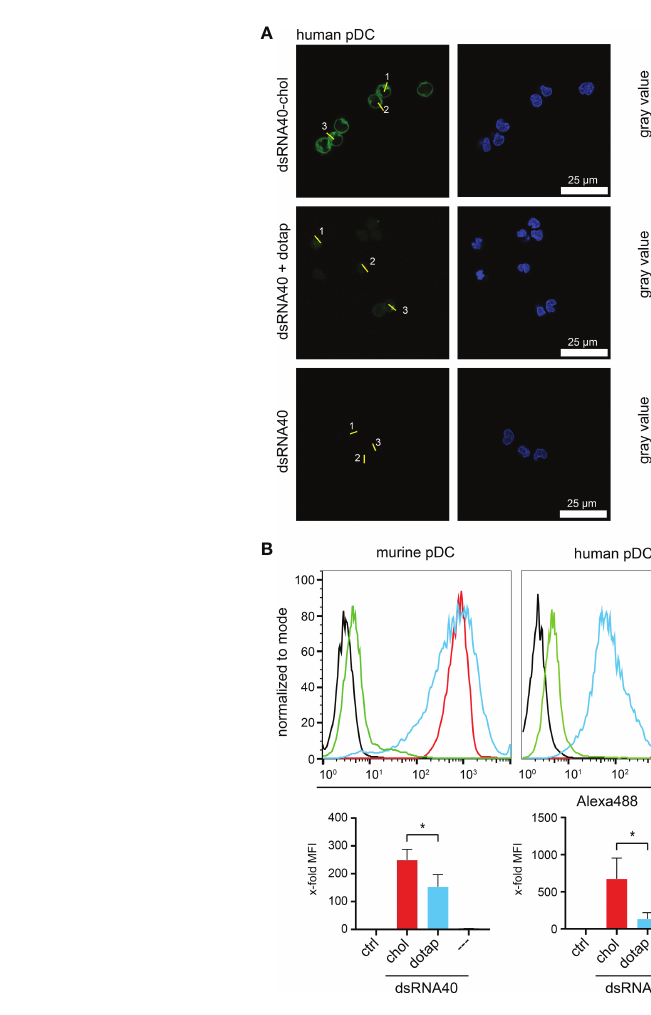
FIGURE 4 | dsRNA40-chol nanoparticles are ef fi ciently taken up by different immune cells. (A) Puri fi ed human pDC were incubated with 0.5 µM of Alexa488-labeled dsRNA40-chol, dsRNA40 complexed to DOTAP or dsRNA40. Cells were extensively washed and fi xed after 1.5 h of incubation and analyzed by confocal laser scanning microscopy. RNA40 is shown in green and DAPI-stained nuclei in blue (left panel, scale bar 25 µm). In the right panel, the fl uorescence intensity pro fi le is plotted as grayscale ( fl uorescence intensity) versus distance (in µM) for individual cells. For every cell stimulation condition, 3 cells were marked by a line (numbered from 1 to 3) and corresponding fl uorescence pro fi le (numbered from 1 to 3) plotted along this line. (B) Murine Flt3L-DC (B220+/CD11c+ pDC), puri fi ed human pDC and monocytes were incubated as described in (B) and uptake of RNA40 was analyzed by fl ow cytometry. Histograms depict one representative experiment out of three independent experiments. Bar charts combine median fl uorescent intensities (MFI) of three independent experiments. Values were normalized to ctrl. Bars indicate mean + SEM. ns: not signi fi cant, *p < 0.05; one-way ANOVA with Sidak ’ s post-hoc